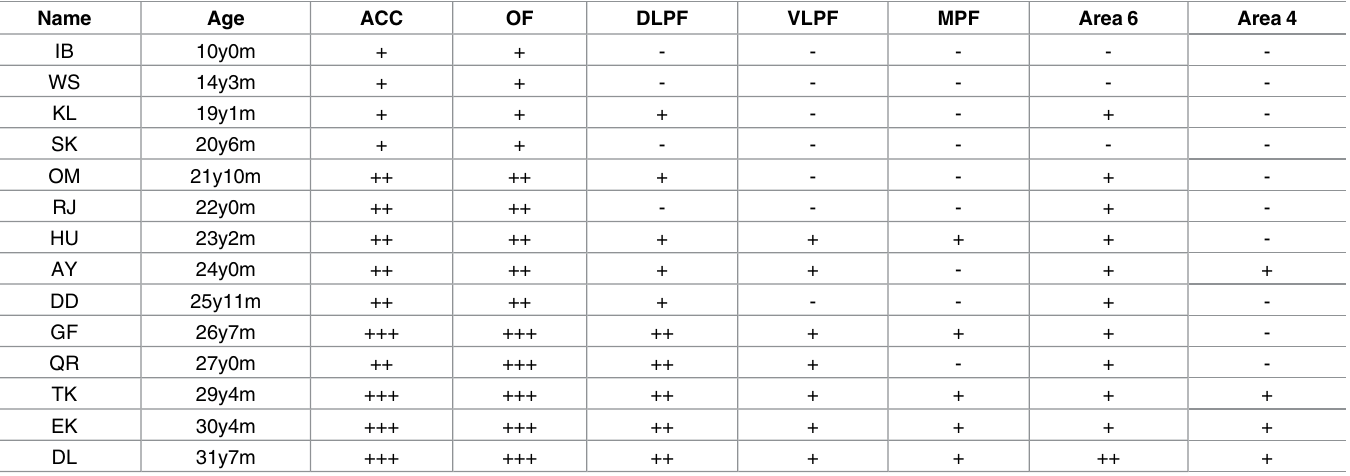
Table 3. Distribution patterns of α -syn-positive neurons in frontal cortical areas. -, none; +, sparse (1-10/ROI); ++, moderate (11-20/ROI); +++, dense (21-/ROI). ACC, auterior cingulatecortex; Area 4, area 4 of the motor cortex; Area 6, area 6 of the motor cortex; DLPF, dorsolateral prefrontalcortex; MPF, medial prefrontal cortex; m, months; OF, orbitofrontal cortex; VLPF, ventrolateralprefrontalcortex; y,